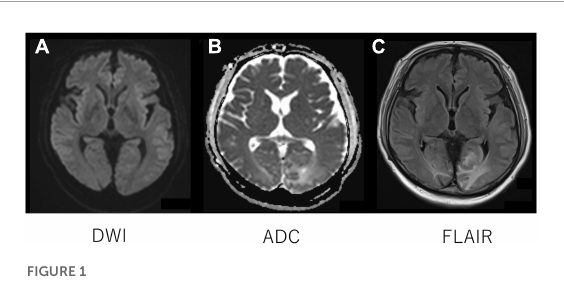
FIGURE1 Head magnetic resonance imaging. Diffusion-weighted